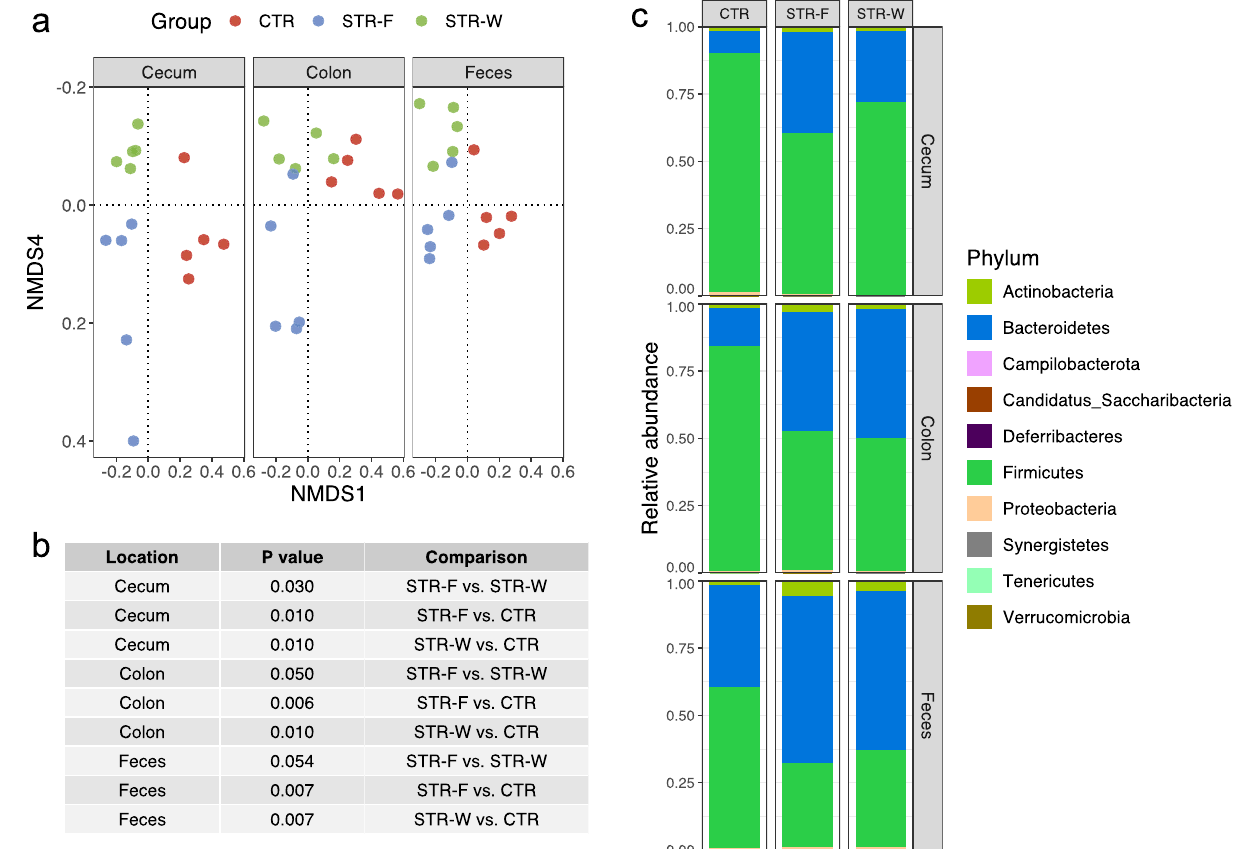
Figure 5. Microbial compositions in cecum, colon, and feces. ( a ) The overall microbial compositions of samples at the ASV level were assessed with and Bray–Curtis distance and visualized with non-metric multi- dimensional scaling (NMDS). ( b ) A table to show the comparison of beta diversity between groups at a location and the P-values are derived from the PERMANOVA models using Bray–Curtis distance. ( c ) Bar plots showing the taxonomic composition of top 10 most abundant